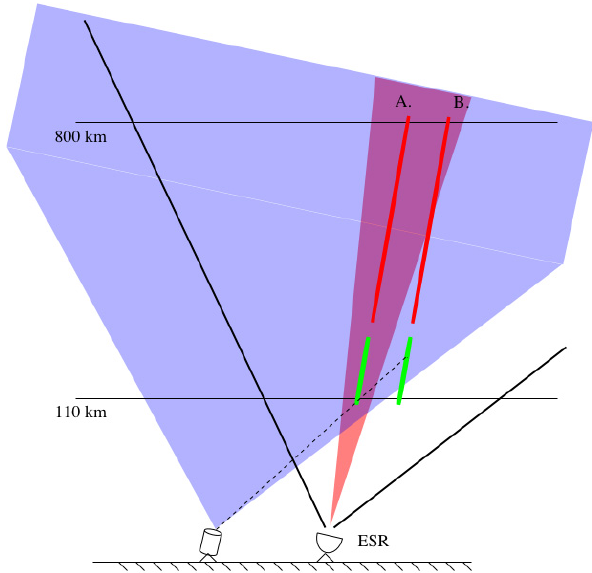
Fig. 5. A drawing of the imager/radar set-up used in the observa- tions. The shaded red triangular region is the radar beam, while the larger shaded blue region is the field-of-view of the camera at the Auroral Station. The strong lines drawn from ESR shows the field- of-view of the camera mounted there. Two different situations, A and B, are shown. In A, both the enhanced radar echo (red) and the auroral ray (green) are within the radar beam at all altitudes, while they are partially outside in B. In the latter case, the aurora will appear to be “in-beam” at 105km when viewed from the Au- roral Station, as shown by the dashed line drawn from the imager through the radar